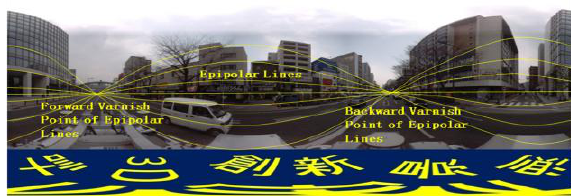
Figure 5. Sinusoid epipolar lines on panoramic image.